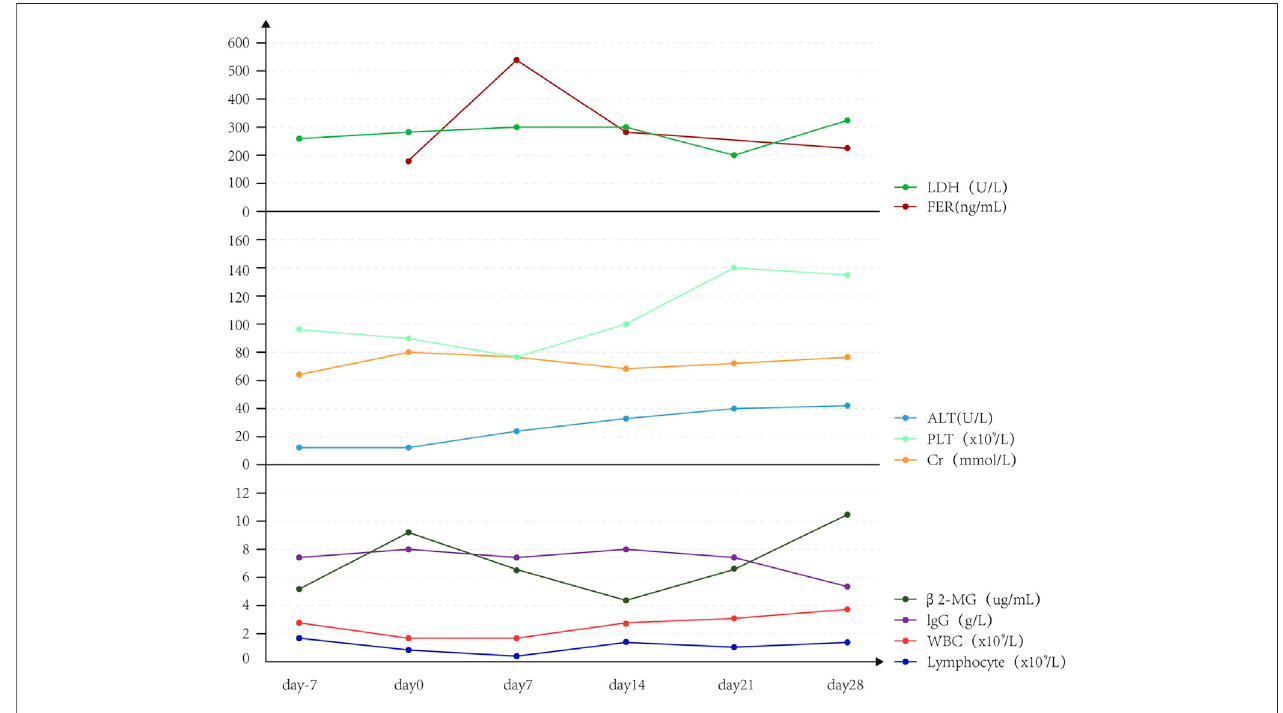
FIGURE 4 | Trend of IL-10 and EBV-DNA copies of Case 2.